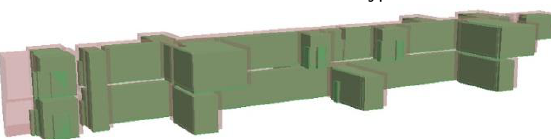
Figure 16. Navigable space including ground floor space (shown in green color) according to walking locomotion type.